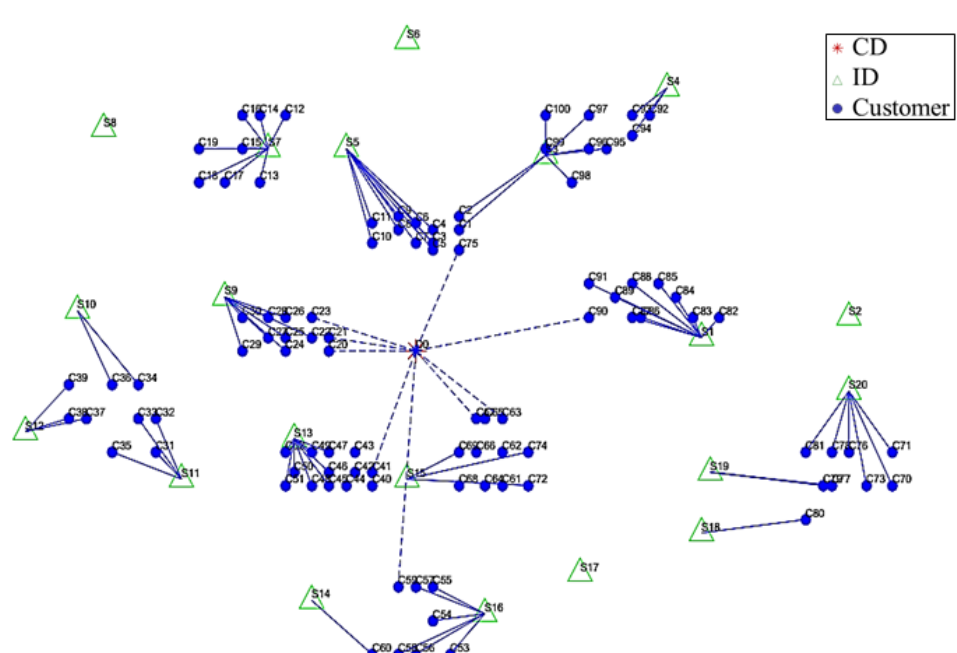
Figure 8. Initial customer clustering with the default range of EVs.